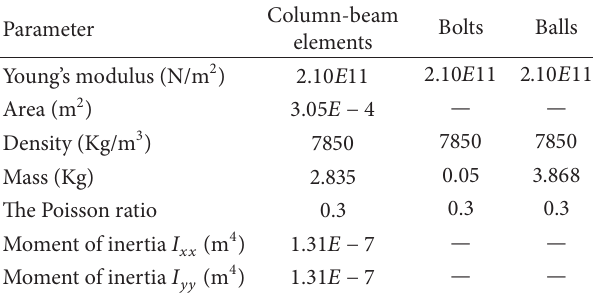
Table 1: Material and geometrical properties of the truss